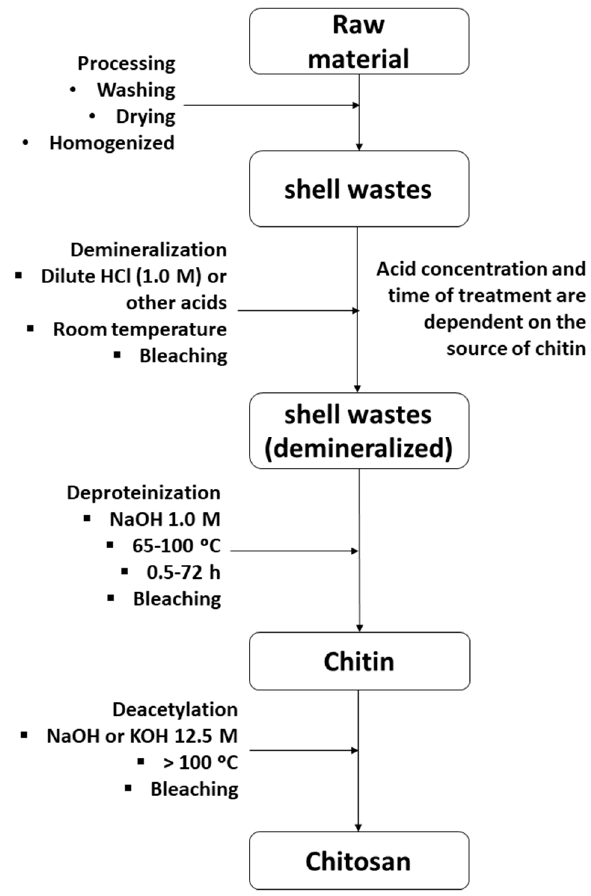
Figure 2. Conventional chemical production process of chitosan from shells of crustaceans.